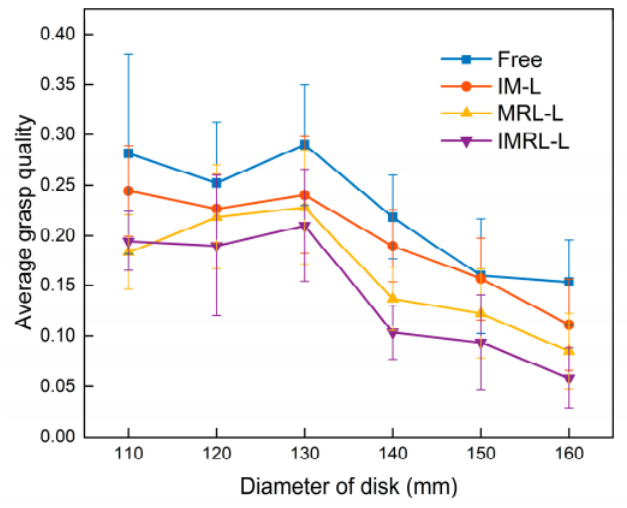
Figure 9. Average grasp quality with the simulator under 4 conditions.